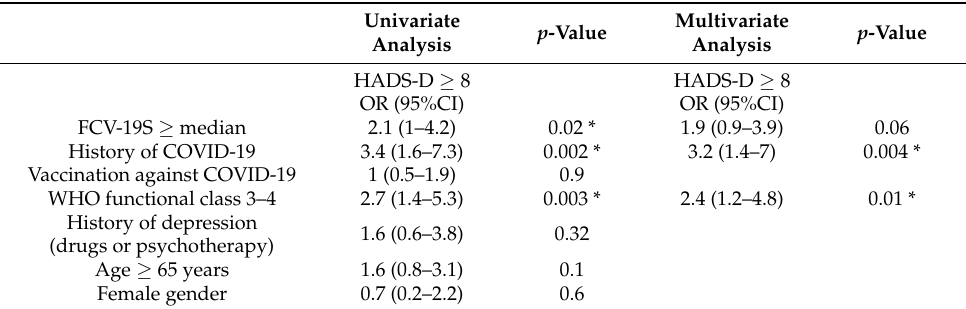
Table 5. Impact of different factors on depression in the HADS scale (HADS-D ≥ 8): results of the univariate and multivariate regression